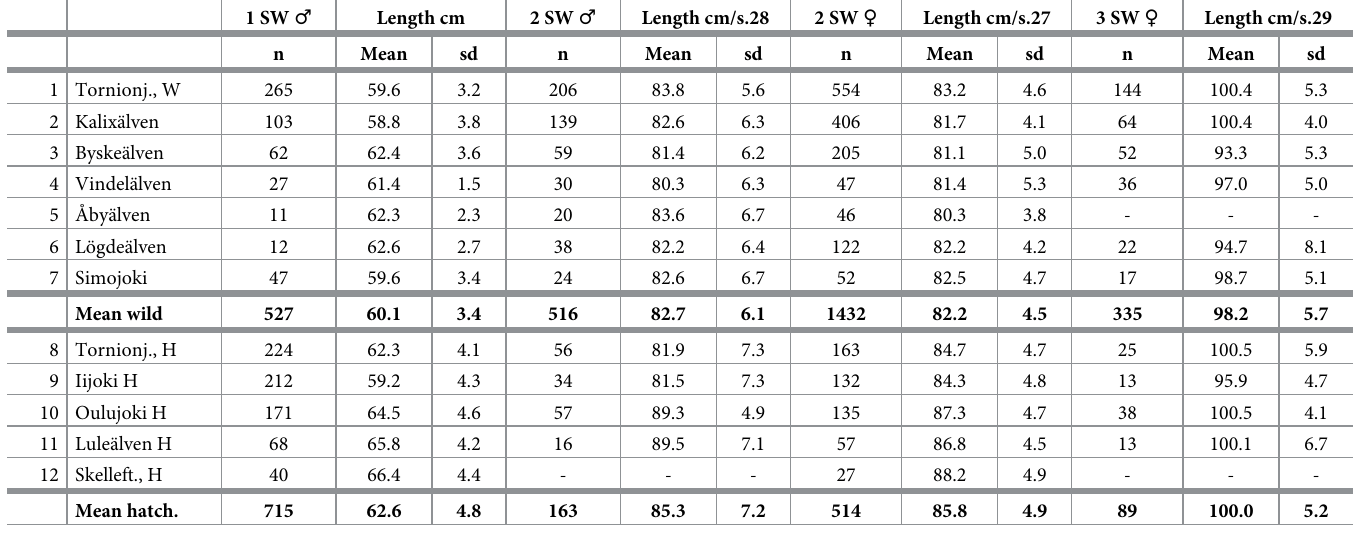
Table 4. Mean length-at-age and standard deviation (sd) of mature Atlantic salmon river stocks caught from offshore catches in the Baltic Sea area in 2000–2013. 1 SW